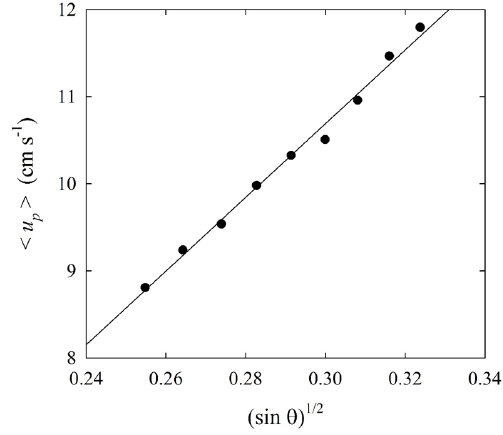
Figure J1. Plot of ensemble-averaged particle velocity (cid:104) u (cid:105) versus √ sin θ involving a steel sphere ( R = 2 . 5mm) moving over glass beads ( r m = 0 . 53mm) giving R/r m = 4 . 7; data from Samson et al.